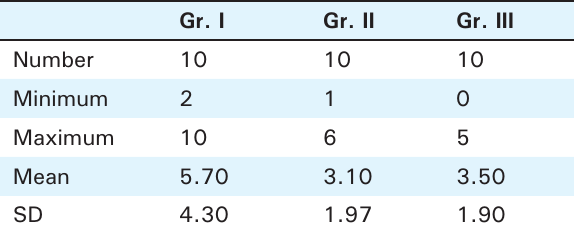
Table 4. Differences of time between research drug